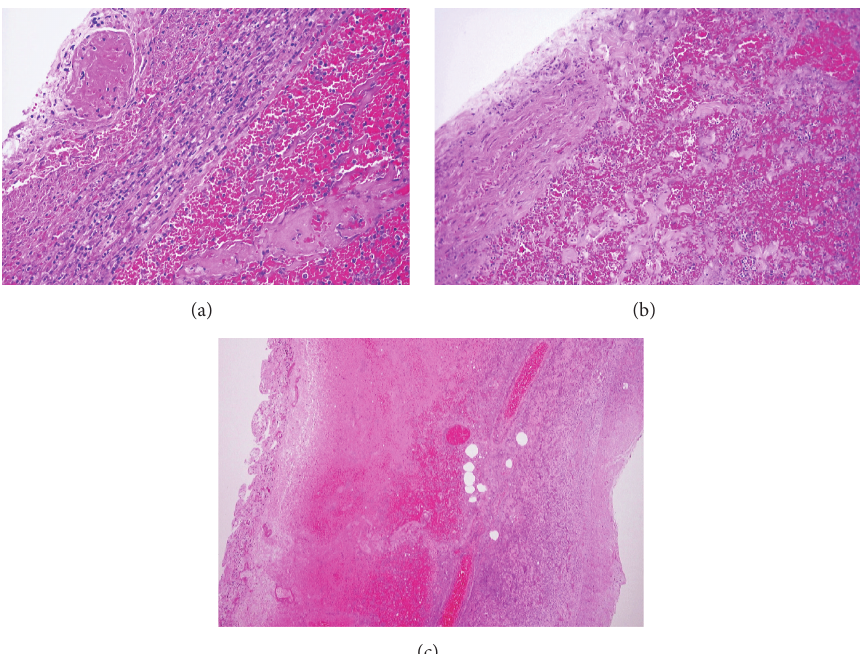
Figure 2: (a) Transmural vascular congestion and extensive hemorrhage. (b) Smooth muscle fibers in the muscularis propria split and fragmented, with strands of myocyte cytoplasm floating in extravasated blood. (c) Focally, only a thin layer of muscularis propria remains beneath the